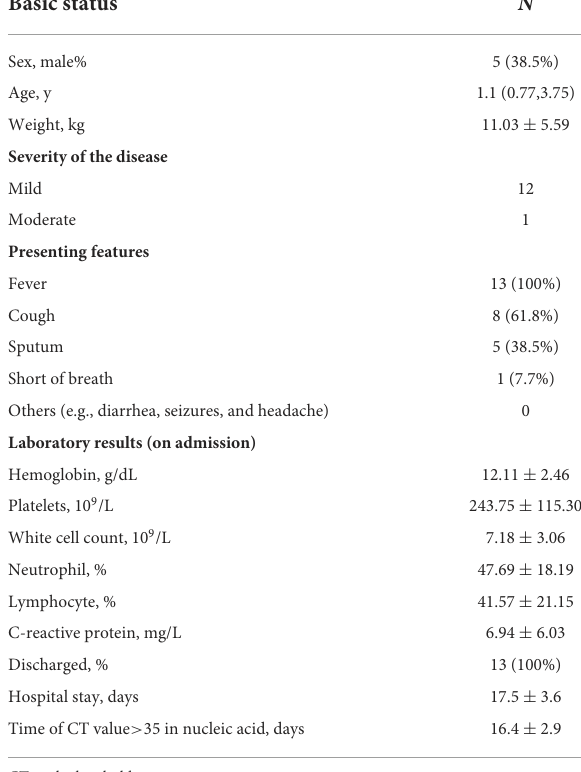
TABLE 1 Clinical features of the patients with congenital heart